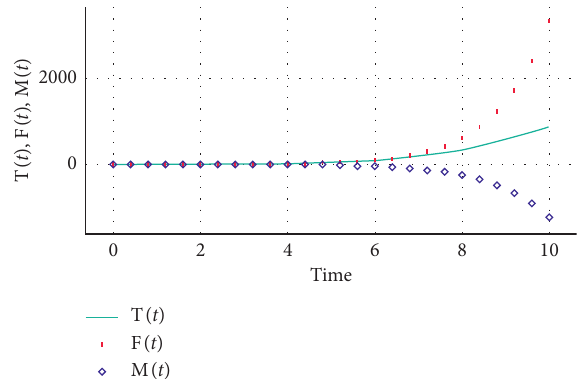
Figure 2: Behavior of the T ( t ), F ( t ), and M ( t ) for Case 2 of the TFM model.